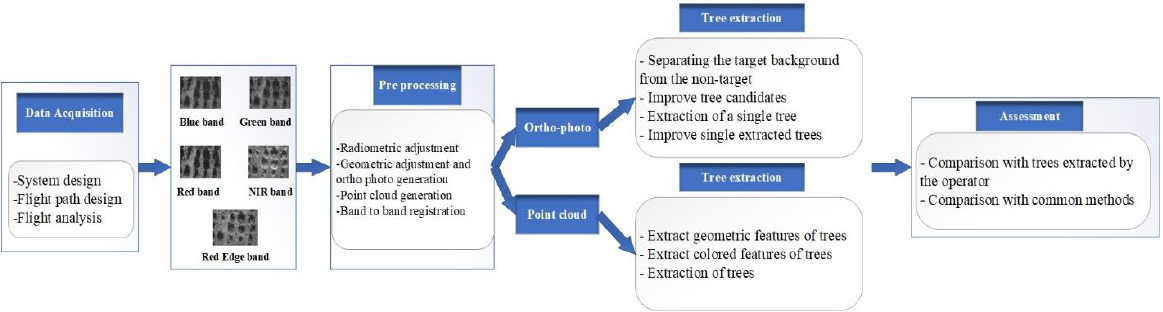
Figure 1. Workflow of the